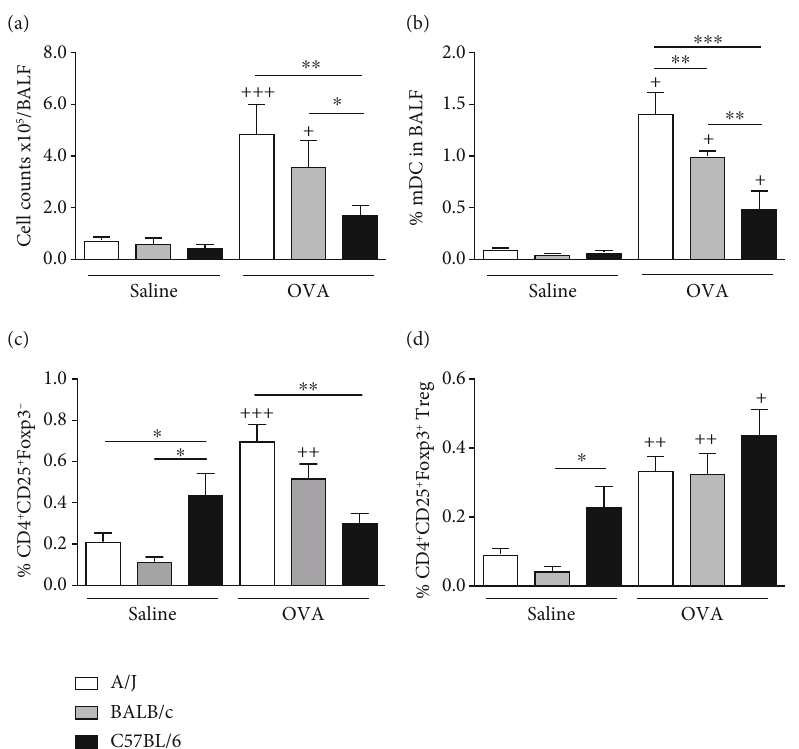
Figure 2: Characterization of in fl ammatory and regulatory cells in the airways of A/J, BALB/c, and C57BL/6 mice challenged with either OVA or saline. Total leukocyte numbers (a), frequency of pulmonary mDCs (b), CD4 + CD25 + Foxp3 - (c), and CD4 + CD25 + Foxp3 + Treg (d) cells in the BALF were evaluated. Values represent mean ± SEM 4-6 animals per group. + P < 0 : 05 , ++ P < 0 : 01 , or +++ P < 0 : 001 as compared to saline-challenged group. ∗ P < 0 : 05 , ∗∗ P < 0 : 01 , and ∗∗∗ P < 0 : 001 are comparisons of di ff erent OVA-challenged mouse